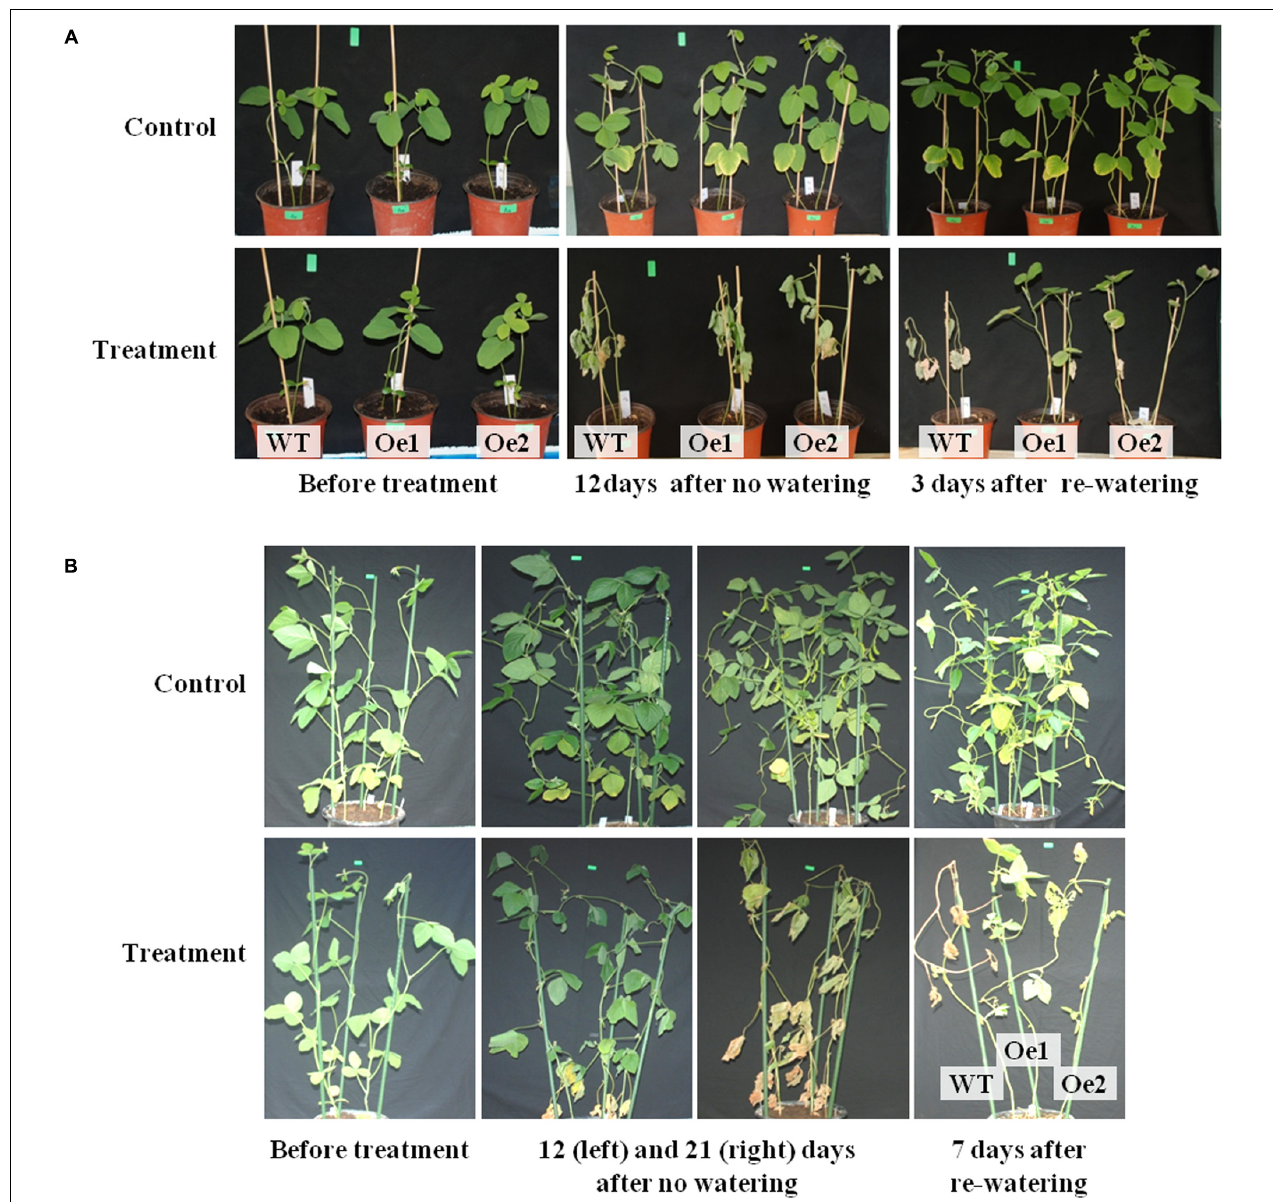
FIGURE 6 | Performance of wild-type (WT) and GmPIP2;9 -overexpression (Oe) plants under drought stress conditions. (A) Drought stress treatment was applied to 2-week-old seedlings of WT, GmPIP2;9 -Oe1, and -Oe2 lines by withholding water for 12 days and then re-watering for 3 days. (B) Water was withheld from 40-day-old WT and GmPIP2;9 -Oe plants for 21 days, and then plants were re-watered for 7